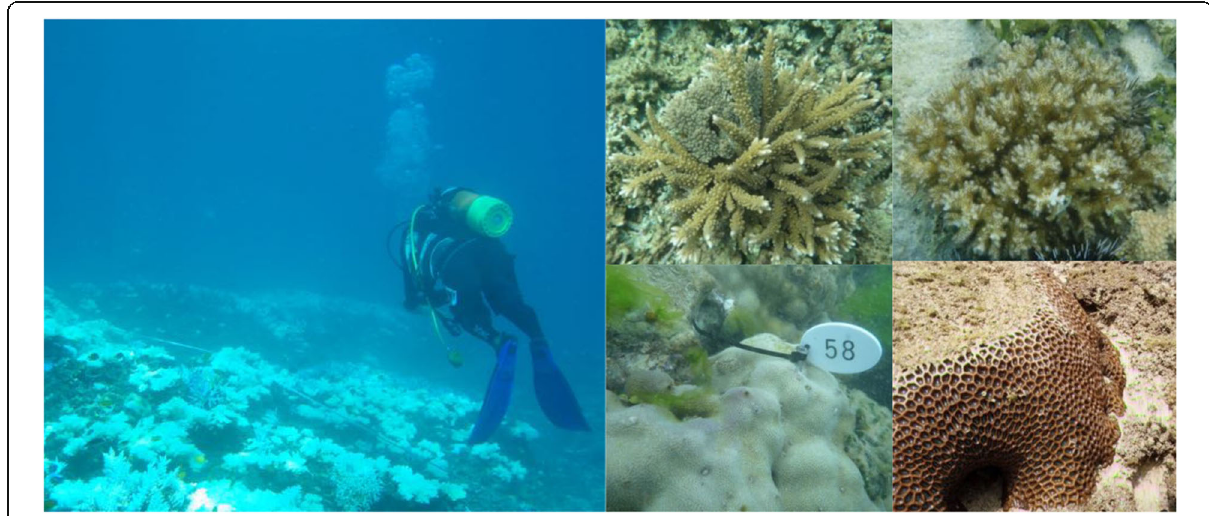
Fig. 7 Left panel shows coral bleaching occurring in the Sekisei Reef (24° N, 124° E), Japan, in September, 2016. Although many coral species are affected by high temperature, it is known that massive or encrusting corals tend to survive even in mass bleaching events. The top of the right panel shows thermal stress sensitive species ( Acropora and Pocillopora ; losers) and the bottom shows stress tolerant species ( Porites and Favites ;